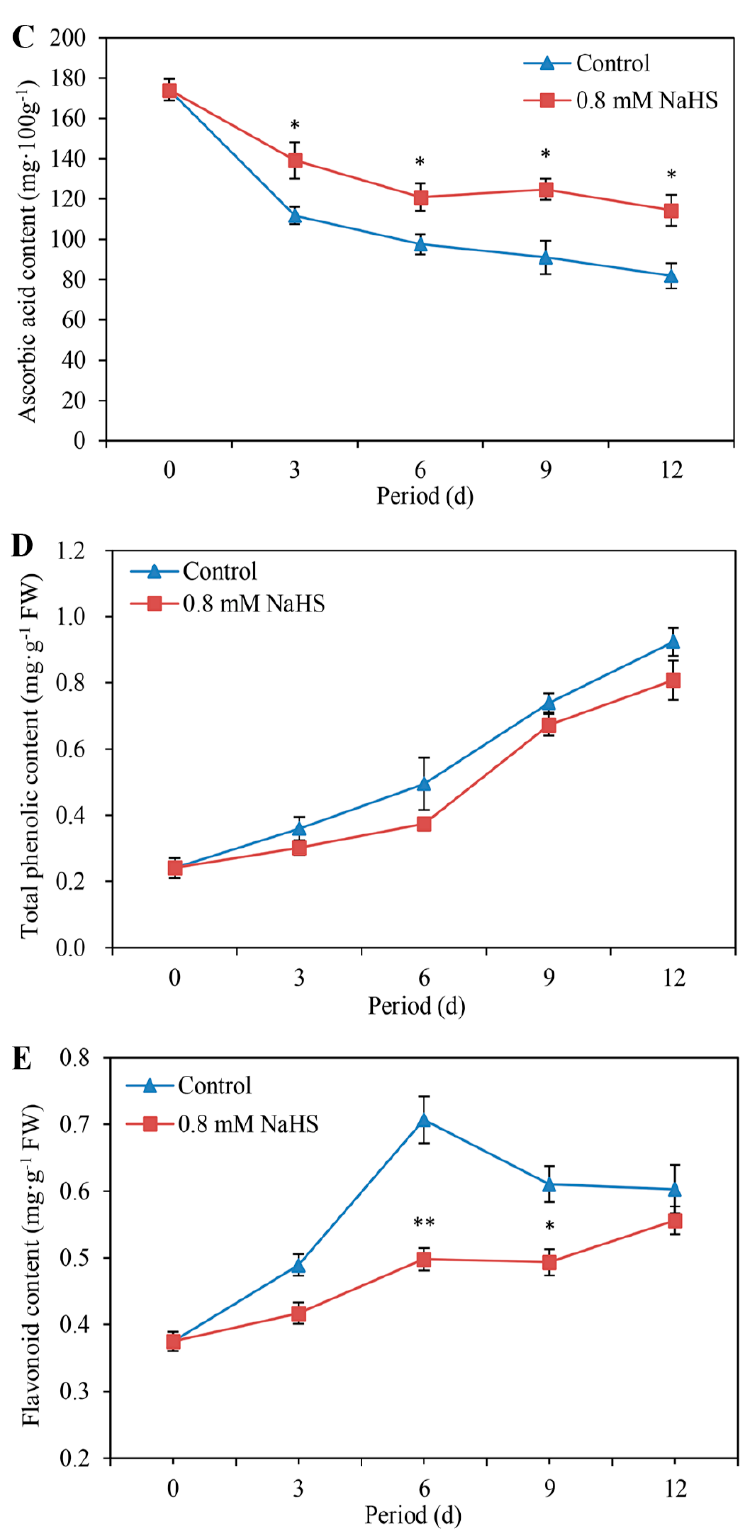
Figure 3. Changes in the contents of soluble sugars ( A ), soluble protein ( B ), ascorbic acid ( C ), total phenols ( D ), and flavonoids ( E ) of Lanzhou lily scales fumigated with or without 0.8 mM NaHS during storage at room temperature for 12 days. The error bars denote the standard errors ( n = 3). The asterisks denote Duncan’s multiple range test for significance: * p < 0.05; ** p < 0.01. d: days.